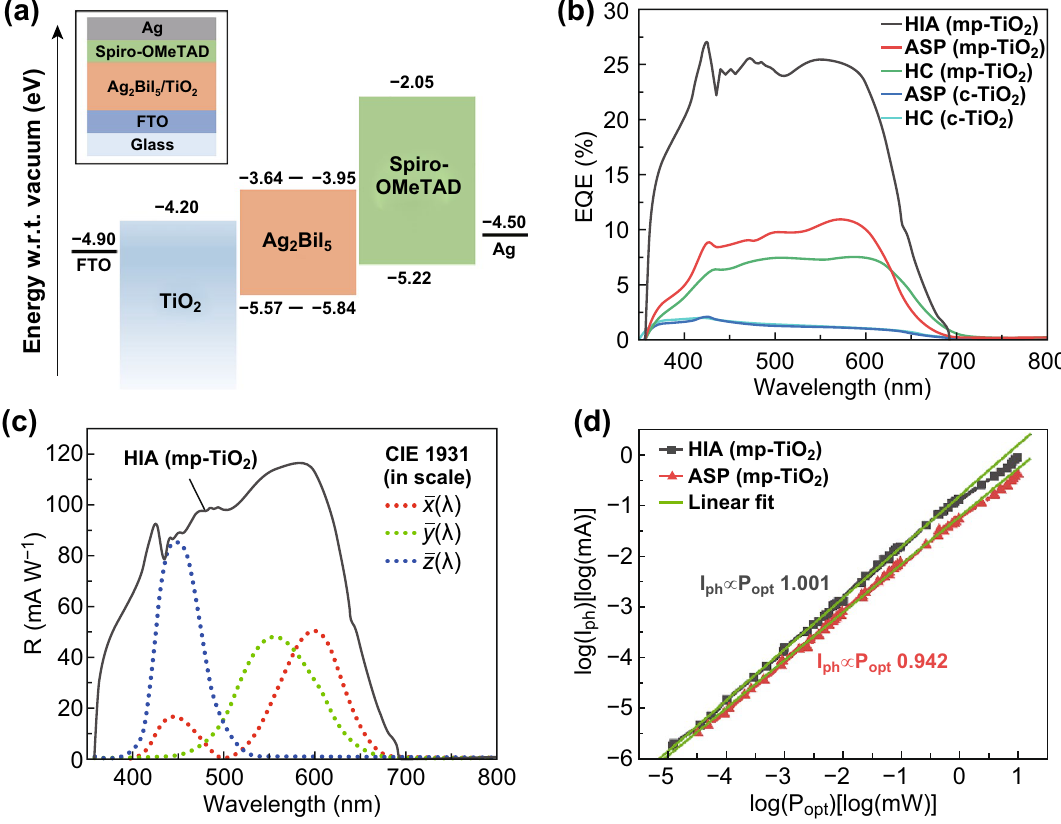
Fig. 3 a Frontier energy levels of all layers within the photodetector stack (inset: device stack). b EQE versus wavelength of photodetectors real‑ ized with different processing methods and on different ETL structures. c Spectral responsivity of HIA (mp‑TiO 2 ) photodetectors. Overlaid are the CIE 1931 XYZ standard observer color matching functions (in scale). d Photocurrent versus optical power of HIA and ASP photodetectors along with power‑law